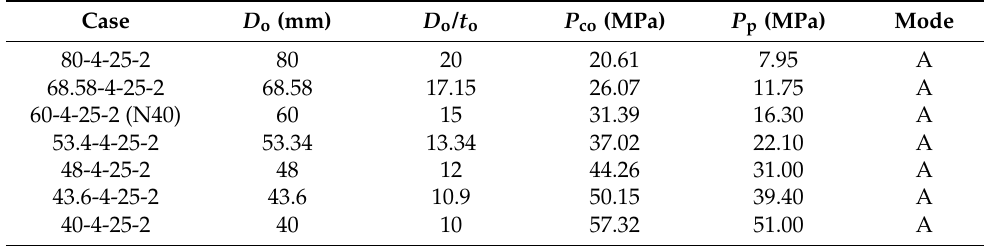
Table 9. Effect of the diameter of the outer pipe.